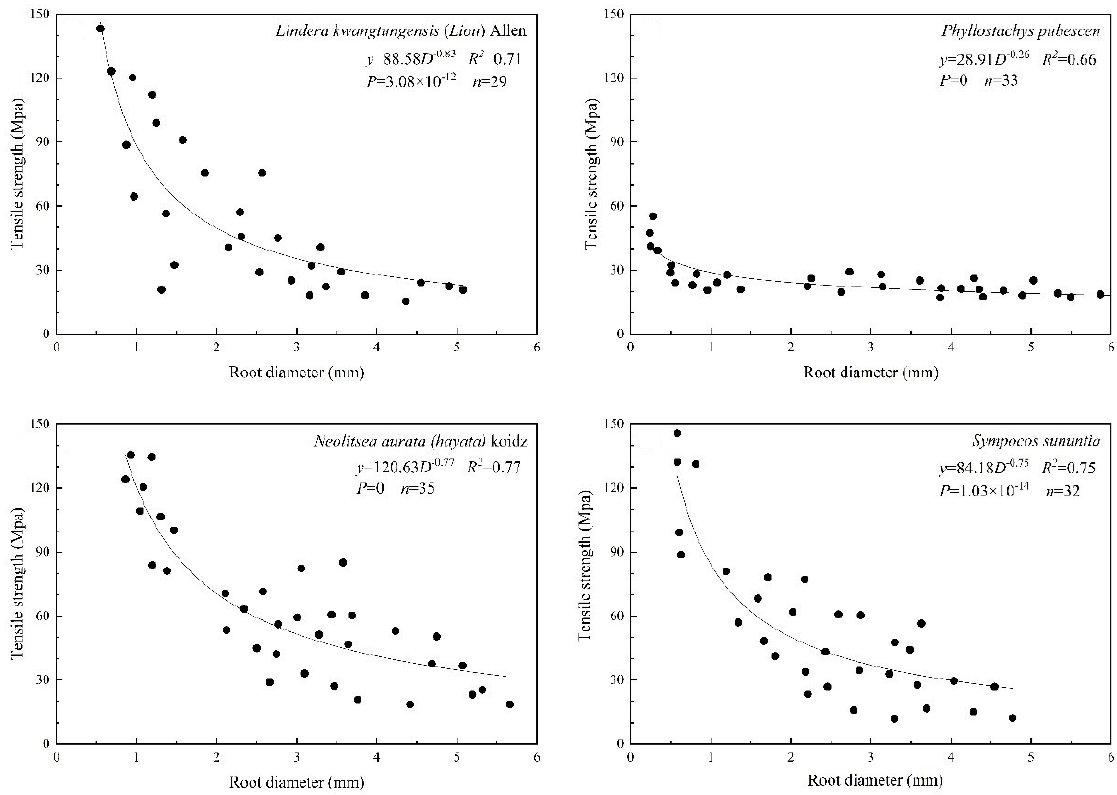
Figure 6. Tensile strength of roots as a function of root diameter in different forestlands.